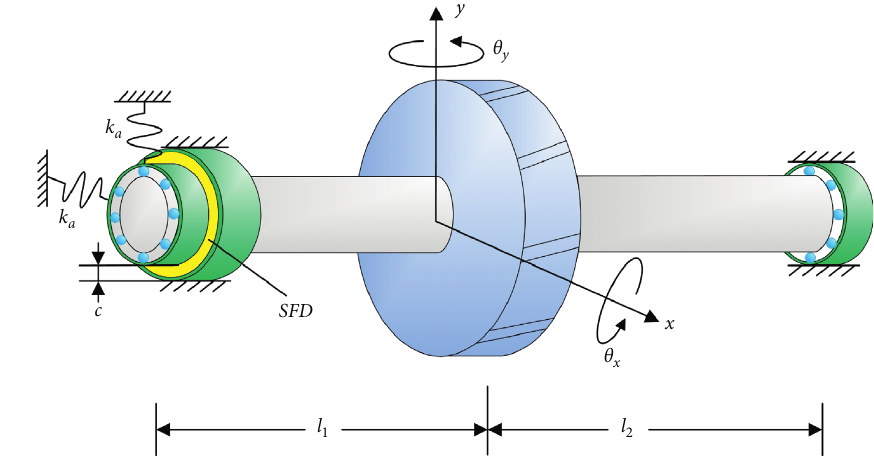
Figure 1: Schematic diagram of a Jeffcott